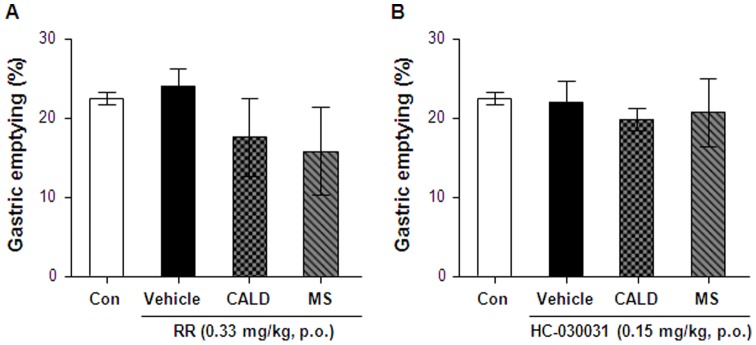
Inhibitory effect of ruthenium red (RR) or HC-030031 on gastric emptying in mice treated with cinnamaldehyde (CALD) or methyl syringate (MS).Phenol red was administered 5 min after treatment with vehicle (1.5% methyl cellulose), CALD, or MS at a dose of 10 mg/kg in the presence or absence of RR (A) and HC-030031 (B). Gastric emptying was evaluated measuring the quantity of phenol red retained in the stomach after 15 min. Columns and vertical bars represent the means ± SEM (n = 4); *p<0.05 compared with the vehicle control.